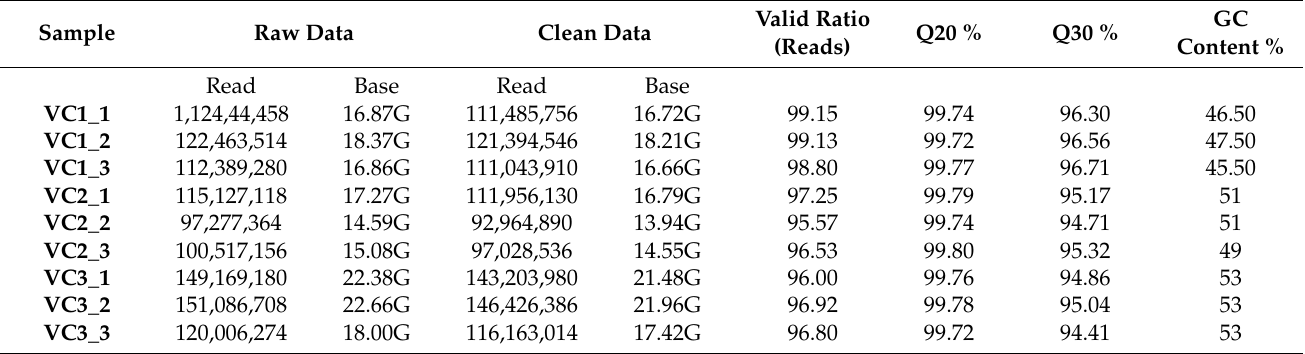
Table 1. Statistical Data of the RNA-Seq Reads for Nine Cambium Libraries in P. tomentosa